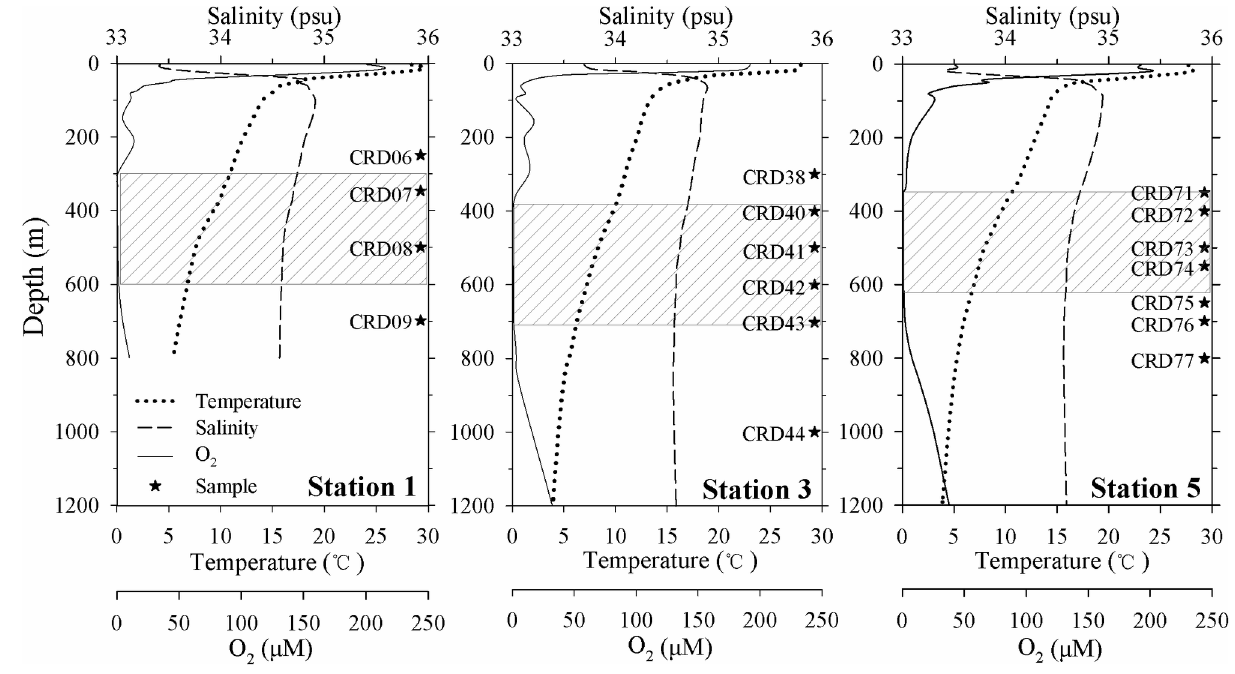
Figure 2. Hydrographic conditions of the sampling stations. Shadow layers indicate the core of the oxygen minimum zones (OMZs) characterized by dissolved oxygen concentration lower than 1.0 μM.